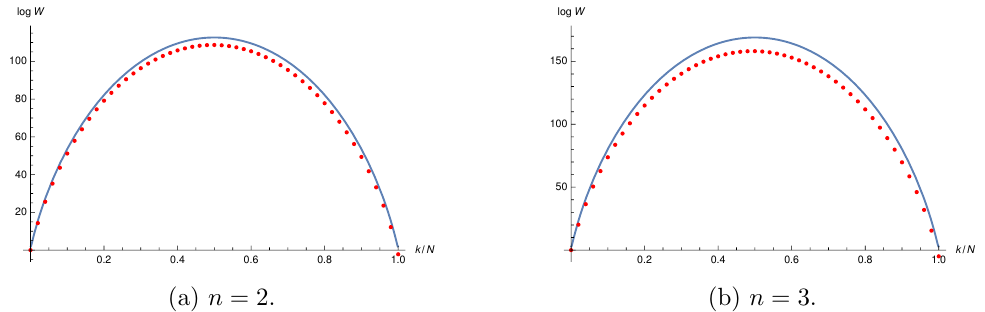
Figure 13. Plot of the log W (cid:21) in the representation (cid:21) = [ n k ] for (a) n = 2 and (b) n = 3 as a function of k=N with N = 100. The red dots are the exact values of log W represent n log W A k